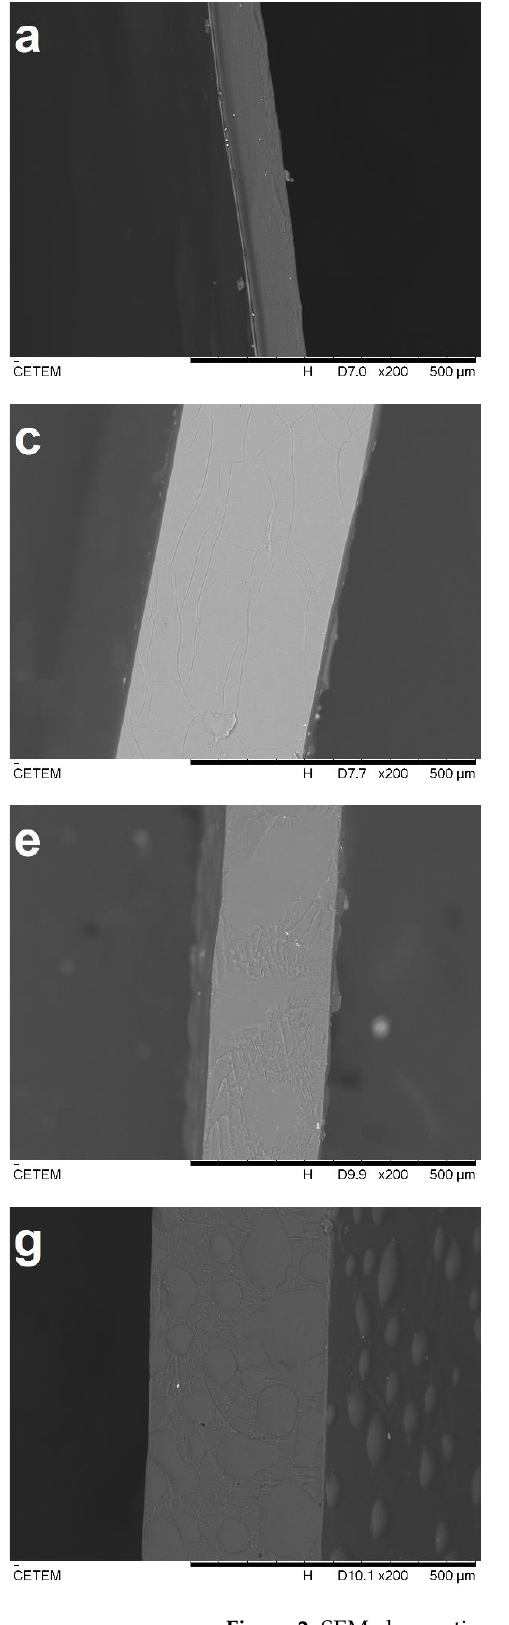
Figure 2. SEM observations of cross-sections of F0/0 ( a ), F5/0 ( b ), F5/0.25 ( c ), F5/0.5 ( d ), F5/1 ( e ), F5/2 ( f ), F5/5 ( g ) and F5/10 ( h ) films at 200 ×